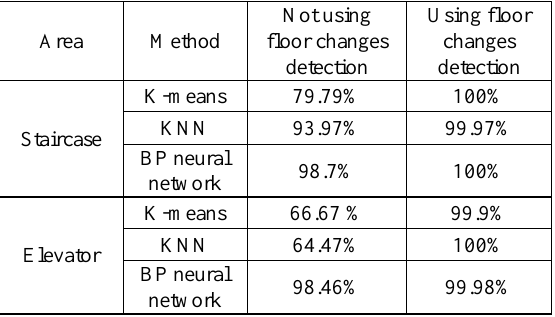
Table 1. Comparison of elevator and staircase in second floor. In this table, the accuracy of identification around elevator is obviously lower than around staircase. Mainly due to the APs in third floor are not separated by walls and arrive to the second floor. At the same time, the density of APs in the third floor is higher than the second floor, make the area in second floor easy to be regarded as third floor. However, there is no switching over for wrong judgement when user step into this area after utilizing our method.